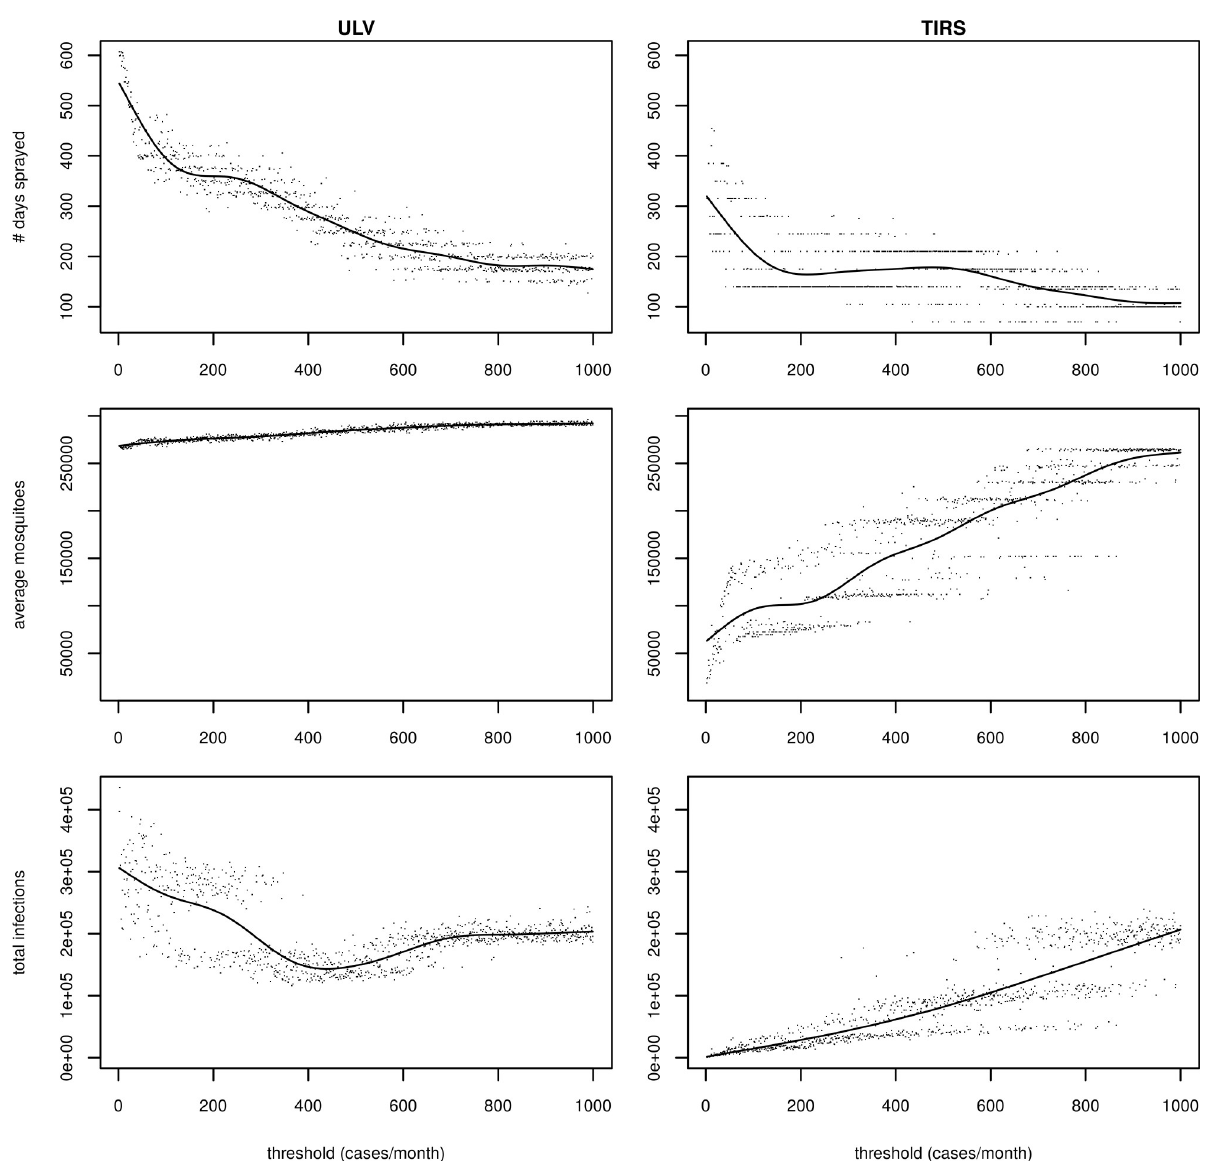
Fig 6. Results when initiating ULV spraying according to a fixed threshold that was monitored on a monthly basis. The top row shows the number of days spent spraying over the 11 year period, the middle row the mean mosquito abundance, and the bottom row the total number of dengue infections. The left column is ULV spraying and the right column TIRS. Each point represents one model simulation, and the line represents predictions by a fitted generalized additive